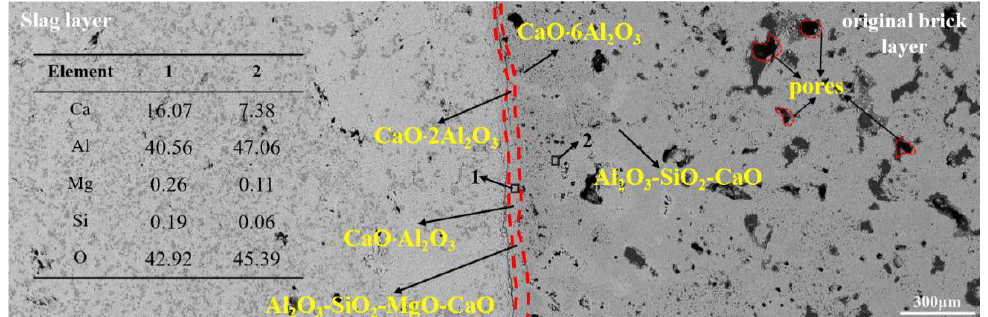
Figure 3. SEM image of CA 6 crucible after corrosion.